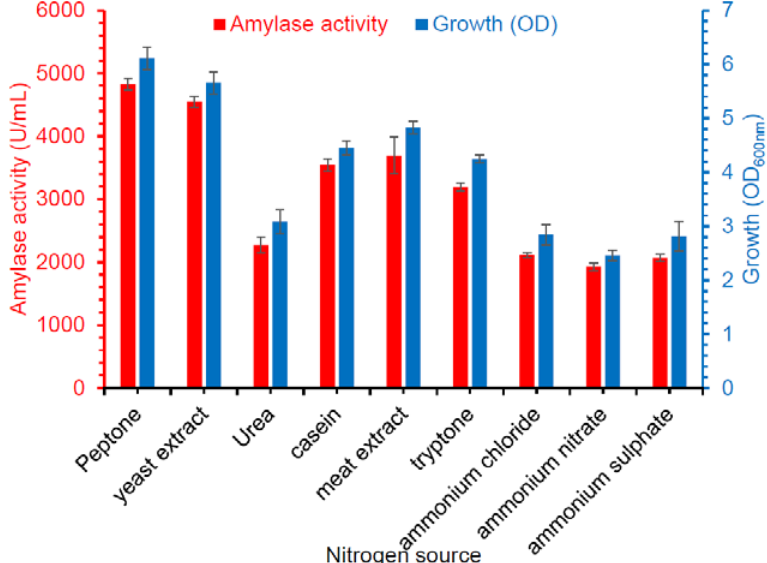
Figure 4. The effect of the nitrogen source (10 g/L initial concentration) on the biosynthesis of amylase from thermophilic marine Bacillus sp. BCC 021-50. The experiment was performed in a molasses (20 g/L) mineral medium, and the culture was incubated at 50 °C for 36 h. The experiments were performed in triplicate and the data presented in the figure are the average of three parallel experiments. Error bars are shown for standard deviation.